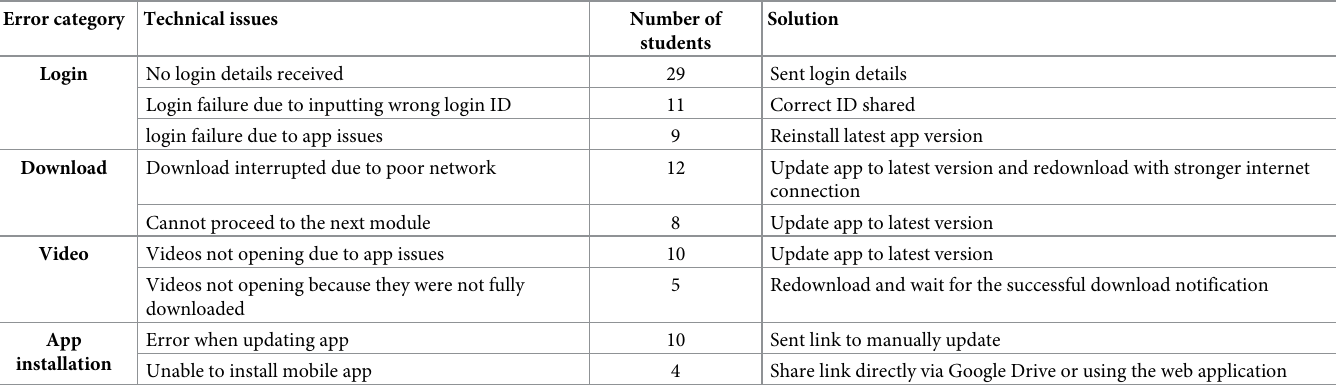
Table 6. Overview of IT errors recorded across five